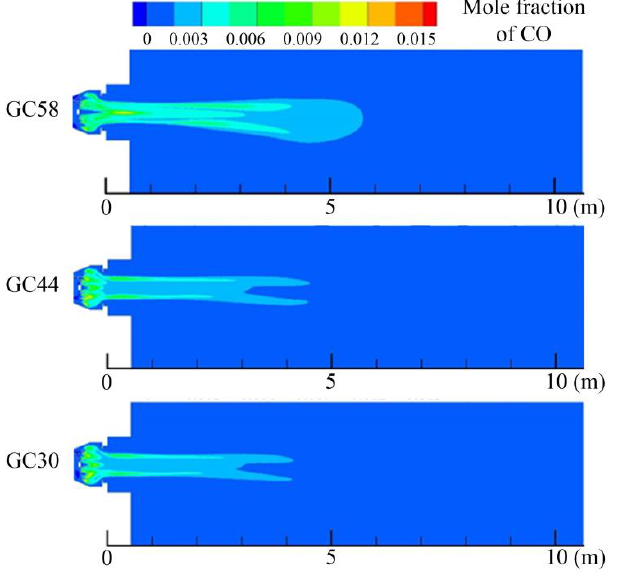
Figure 10. The distribution of Mole fraction of CO for GC58, GC44 and GC30 at z = 0.